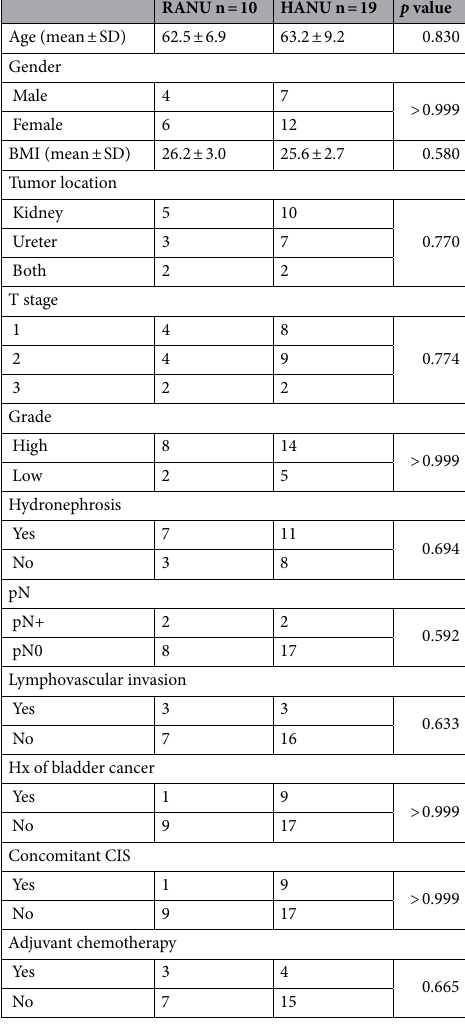
Variable (mean ± SD,